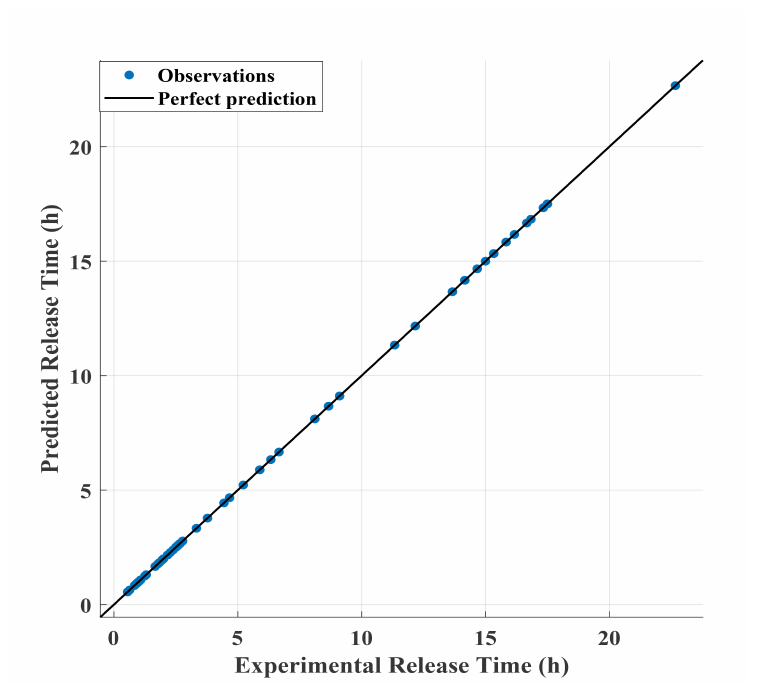
Figure 3. Comparison of experimental and machine learning model results of release time.